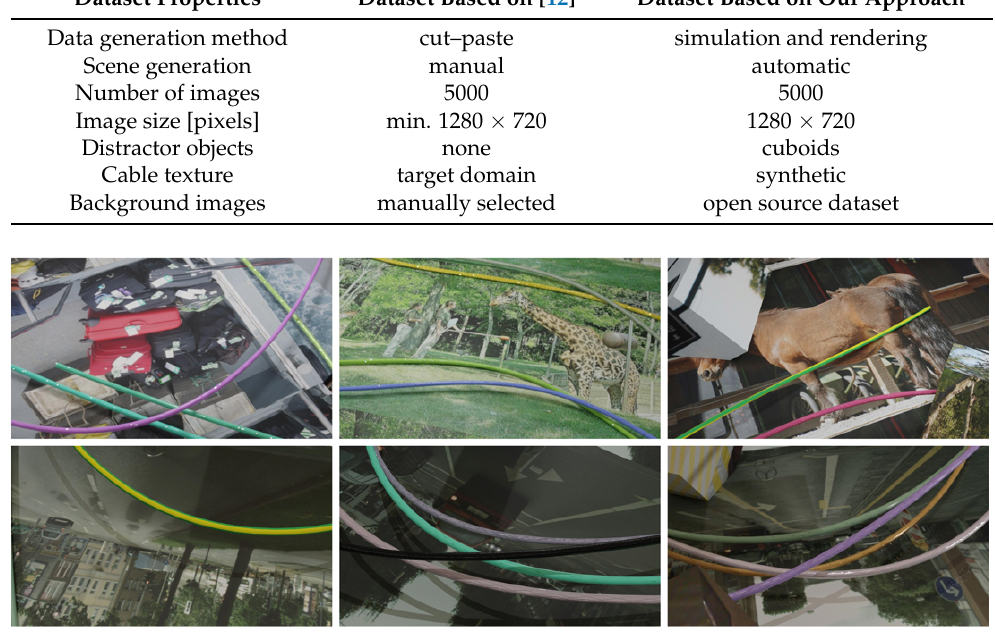
Figure 6. Exemplary images generated with our method for the electric cable